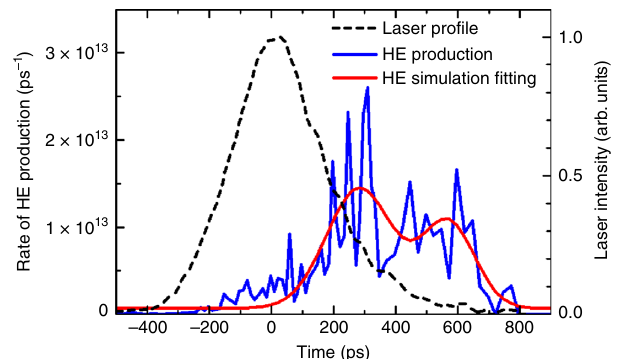
Fig. 5 Temporal evolution of hot electrons. The production rate of hot electrons is obtained from the hydrodynamic simulation (blue); red line shows a two-parameter low resolution fi t. The black dashed line shows the laser temporal pro fi le for comparison